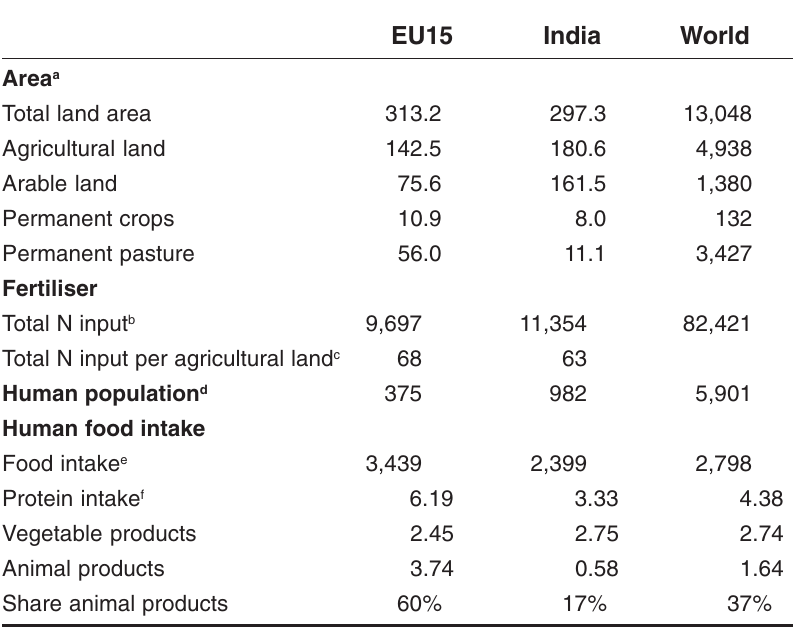
Land Use, Fertiliser Consumption, Human Population, and Human Food Intake in EU15, India, and the World in